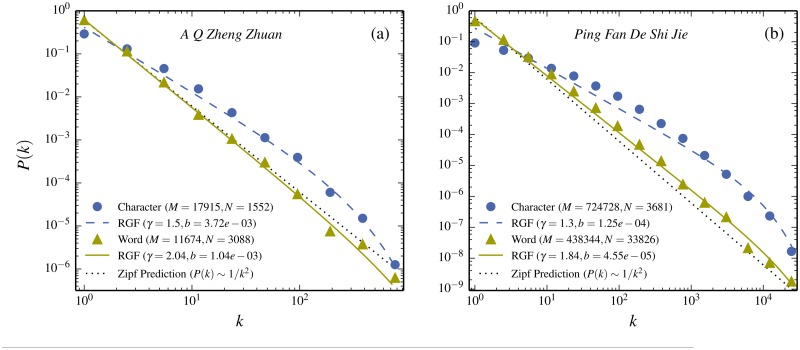
Comparison between Chinese texts in characters and words.(a) Comparison between characters and words for the novel A Q Zheng Zhuan by Xun Lu together with the respective RGF-predictions. (b) The same comparison for the novel Ping Fan De Shi Jie by Yao Lu. Filled dots correspond to the binned data for Chinese characters and filled triangles the data for words. Full and dashed curves correspond to the respective RGF-predictions and dotted straight lines are the Zipf’s law expectations for the word-frequency distribution. The respective “state”-variables (M, N, k
max) and the corresponding RGF-predictions are given in Table 1. Note that the translation between words and characters is a deterministic process. Yet the “state”-variables (M, N, k
max) suffice to predict the change in frequency distribution caused by the translation between words and characters.